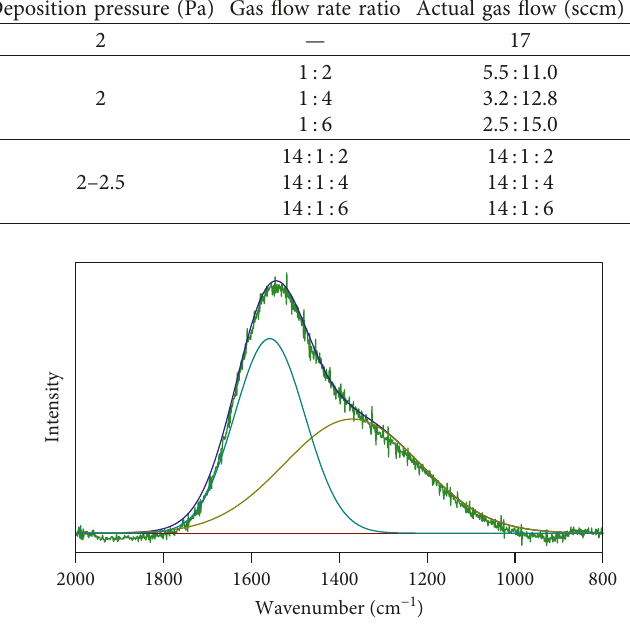
Figure 2: Raman curves fitting of DLC film.